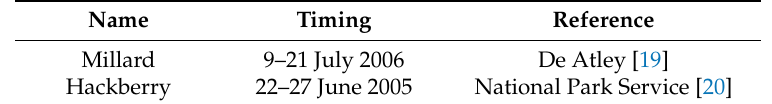
Table 3. Wildfire names and timing.